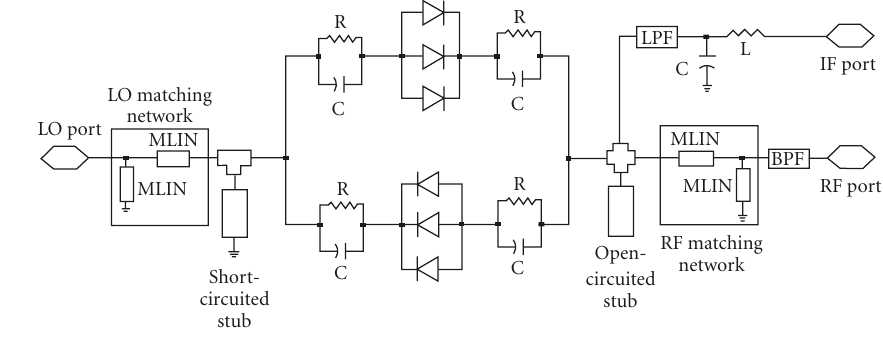
Figure 8: EHM structure used in our design.